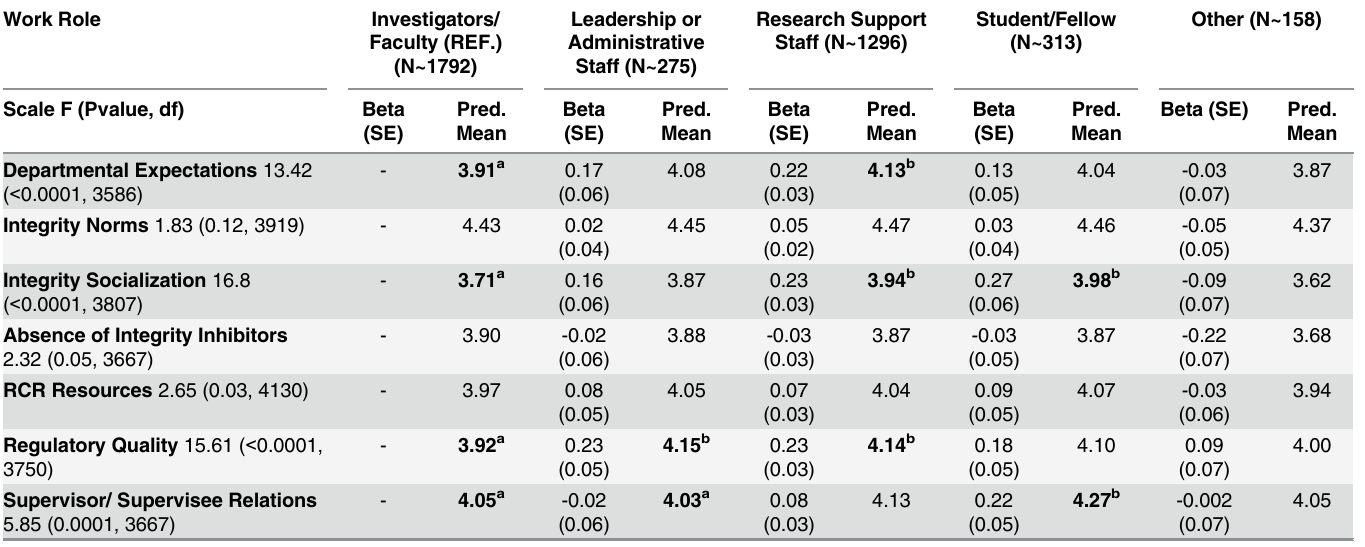
Table 4. Generalized Linear Mixed Model Regressions of SOURCE scales by respondent characteristic of work-role. Work Role